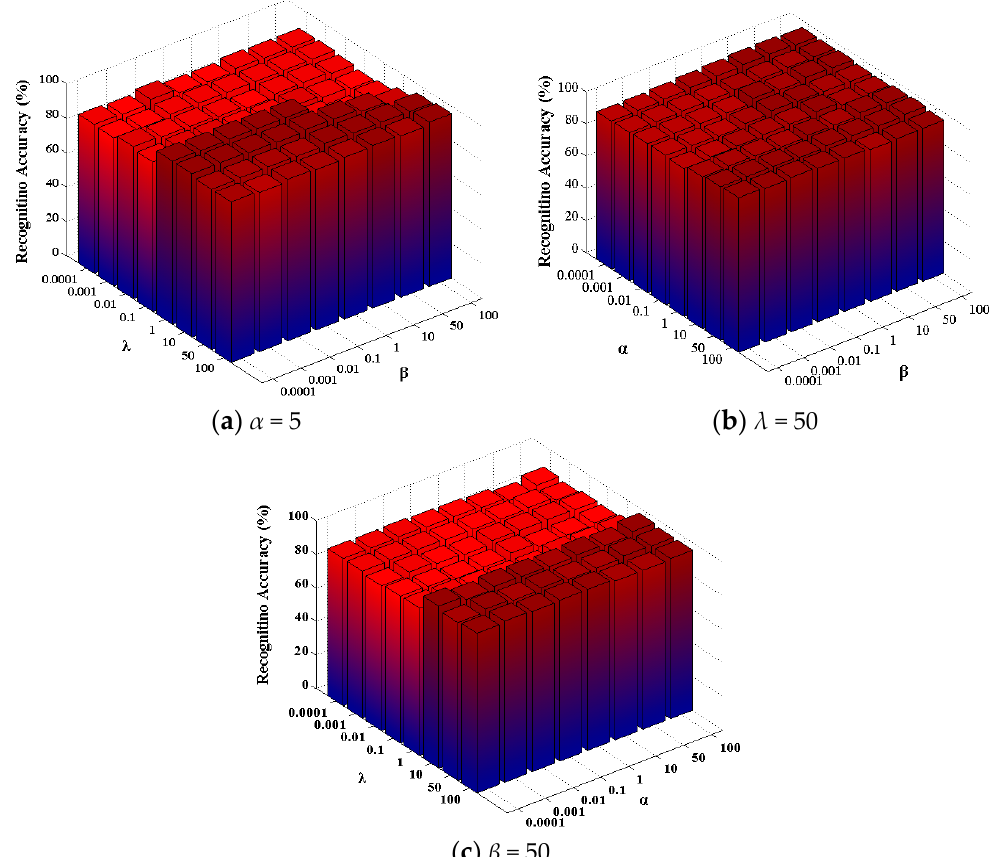
Figure 4. Sensitivity analysis of α , β and λ on ORL dataset. ( a ) Tuning β and λ with α fixed; ( b ) tuning α and β with λ fixed; ( c ) tuning α and λ with β fixed.